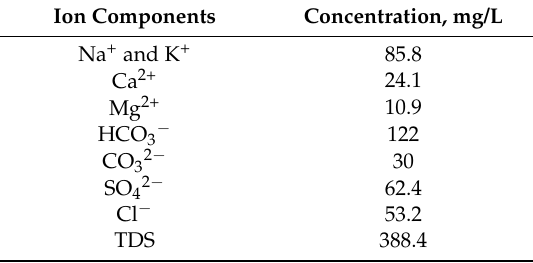
Table 2. Ion component concentrations in